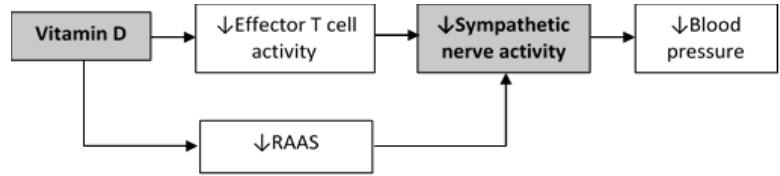
Figure 5. Vitamin D Decrease Sympathetic Nerve Activity and Affect to Lowered Blood